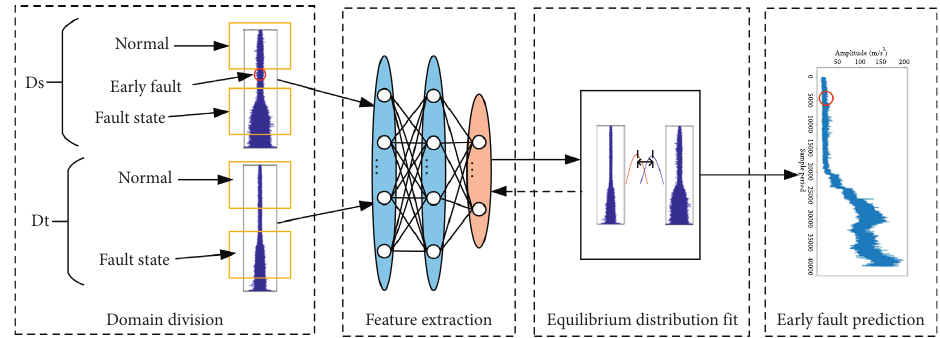
Figure 3: DCAE-TCN model structure based on transfer